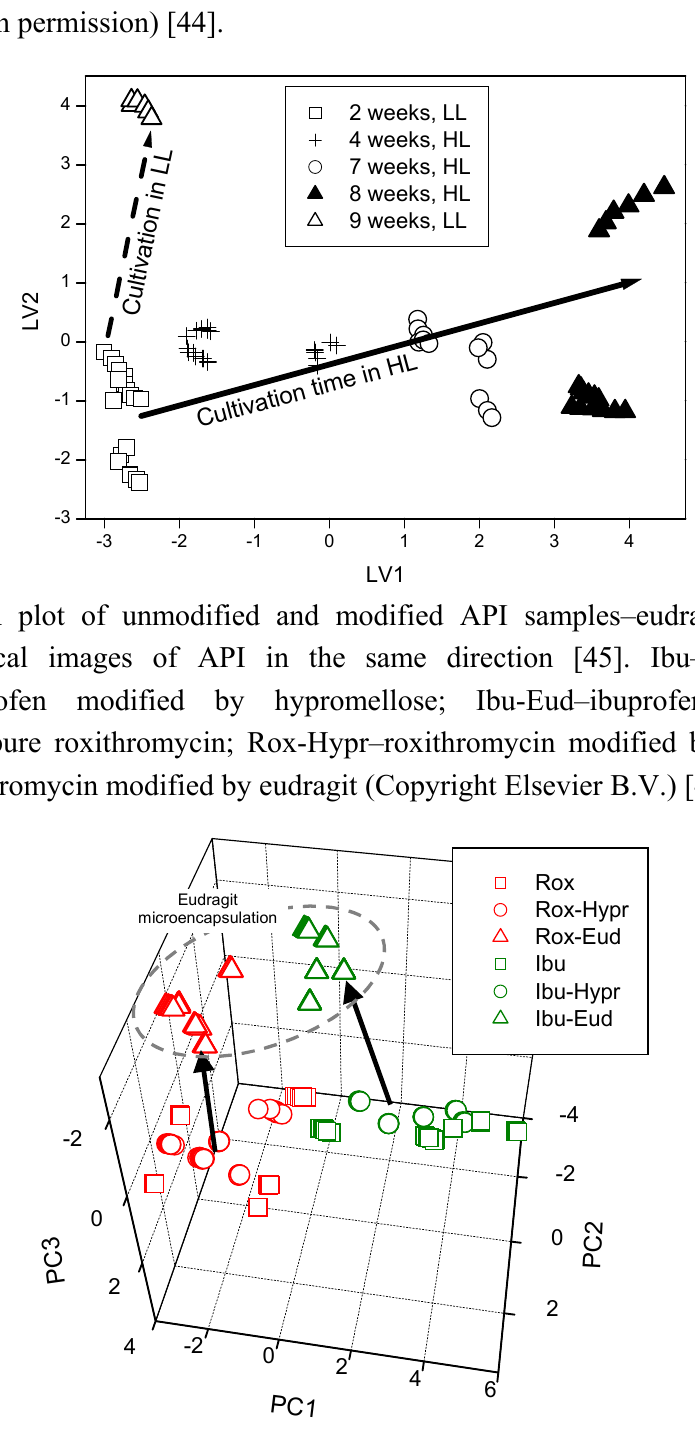
Figure 6. PLS plot of guinea grass samples cultivated for various time in high light (HL) and low light (LL) conditions (Copyright Wiley-VCH Verlag GmbH & Co. KGaA.